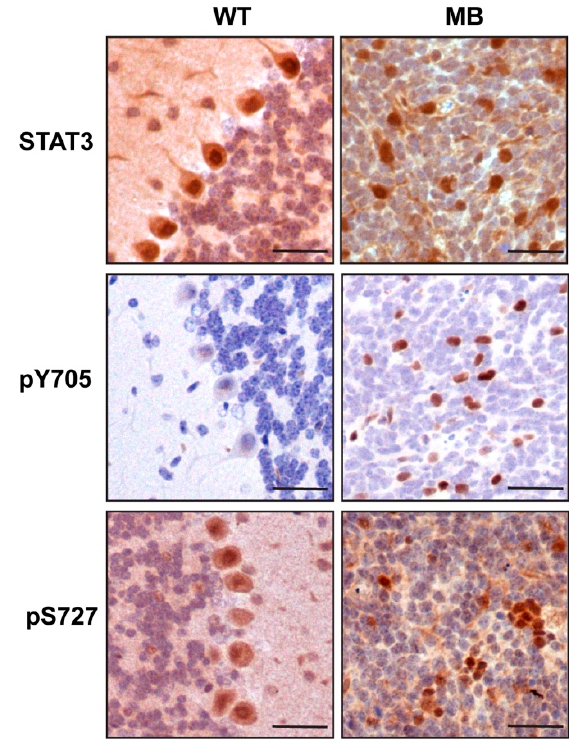
Figure 1. Elevated STAT3 expression and phosphorylation in SHH MB. Immunohistochemical staining for total STAT3, pY705 STAT3 or pS727 STAT3 in normal cerebellum and SHH medulloblastoma tumors from Ptch1 LacZ/+ mice. Representative fields from at least three independent mice. Scale bar = 100 μ m .